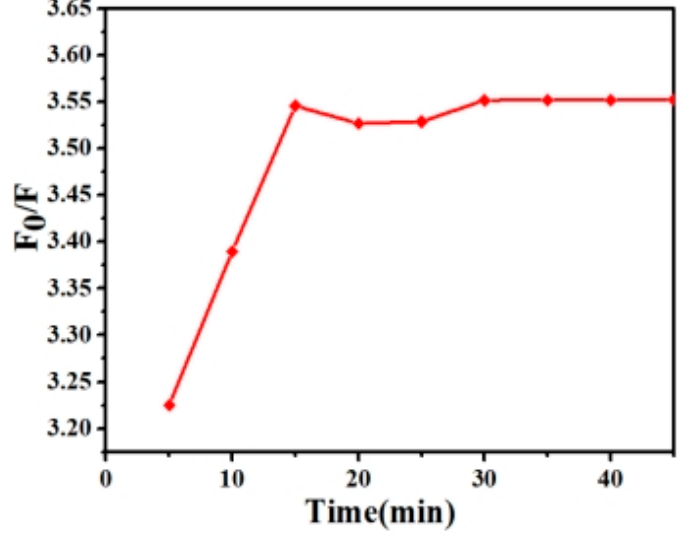
Figure 2. The plot of relative fluorescence intensity versus time.